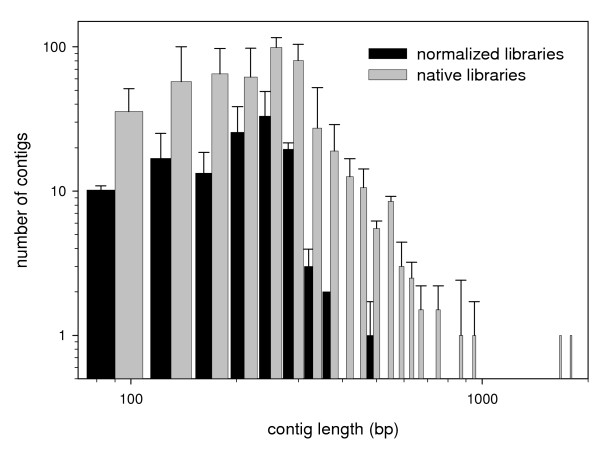
Length of contigs as averaged (± SD) between the normalized and native libraries. Note the logarithmic axes.